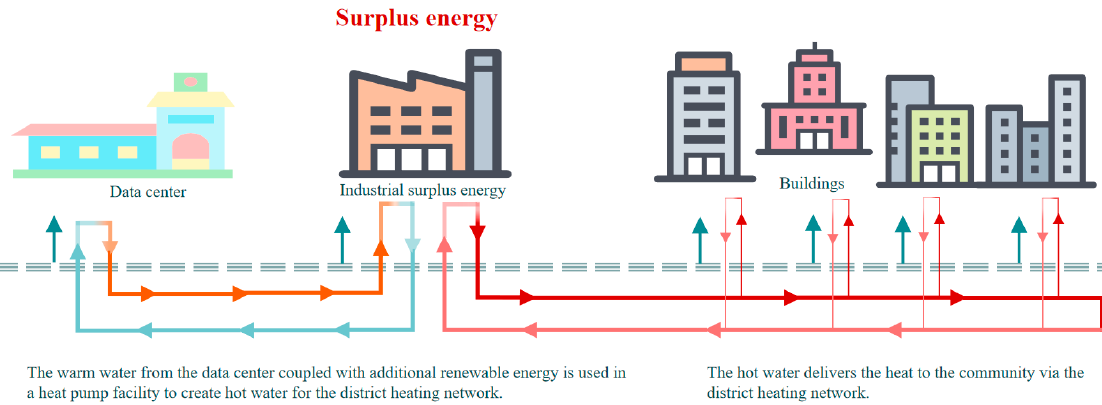
Figure 1. A District Heating System (DHS).